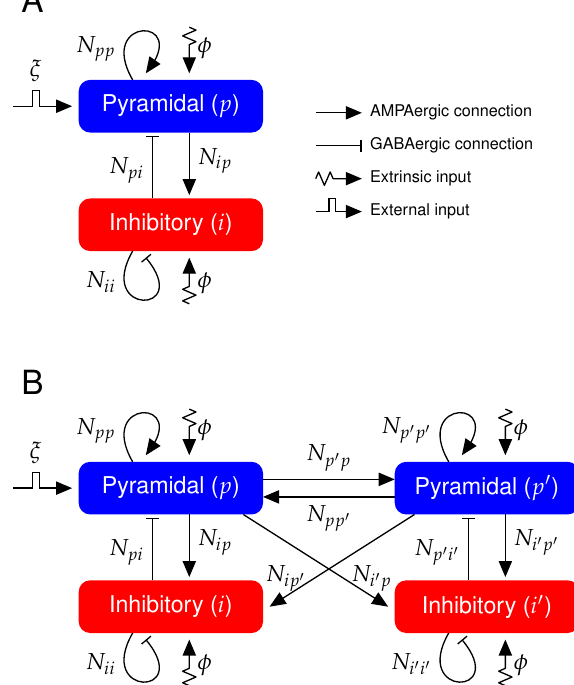
Figure 1. Diagram of the neural mass model. ( A ) One cortical column containing one pyramidal and one inhibitory population. Coupling between pyramidal and inhibitory populations are mediated through AMPAergic and GABAergic connections (see Tables 1 and 2 for symbol description and parameter values). ( B ) Neural mass model describing two mutually coupled cortical columns. Connections between two cortical columns are only AMPAergic, i.e., only the pyramidal populations target both pyramidal and inhibitory populations from the other cortical column (see Tables 1 and 3 for symbol description and parameter values). ξ represents the transient external input impinging only in one cortical